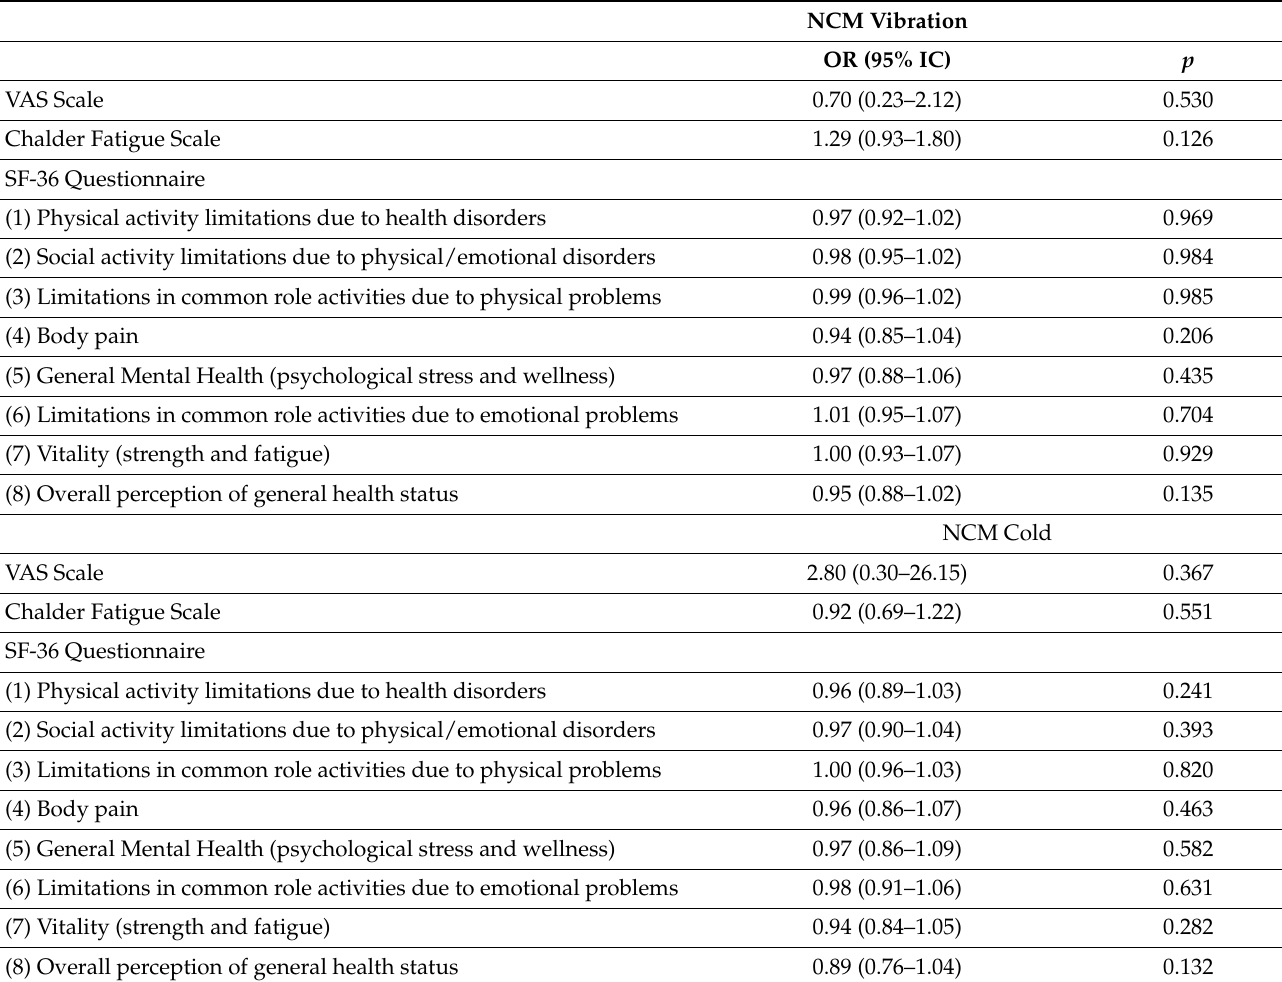
Table 4. Relationship between NerveCheck Master and fibromyalgia scores ( n =